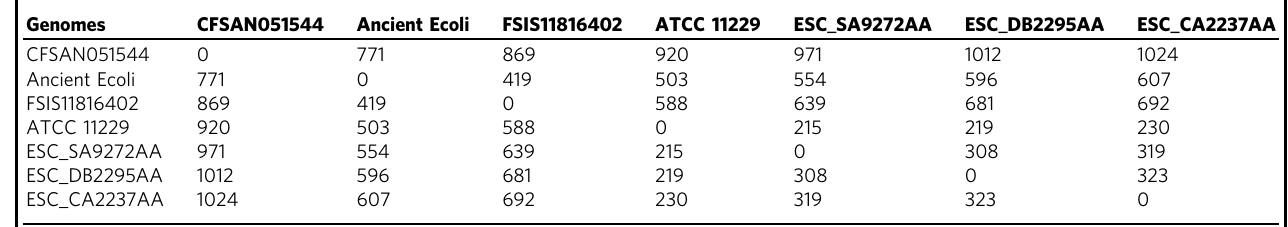
Table 2 SNP distances of seven strains from the ST4995